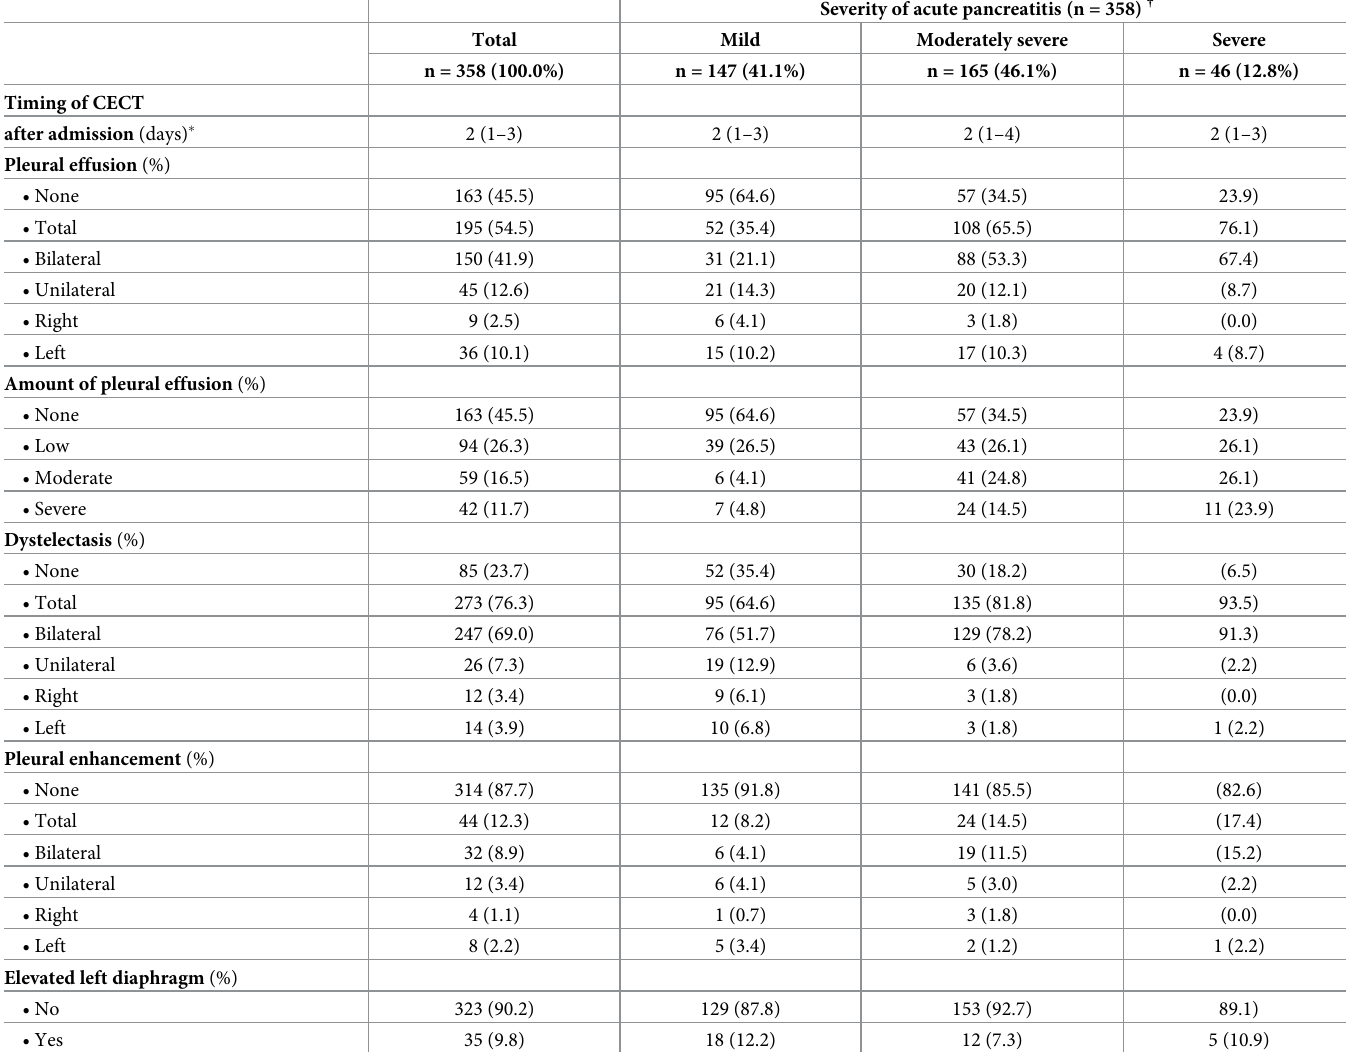
Table 2. Early pleuropulmonary findings in patients with acute pancreatitis (n =